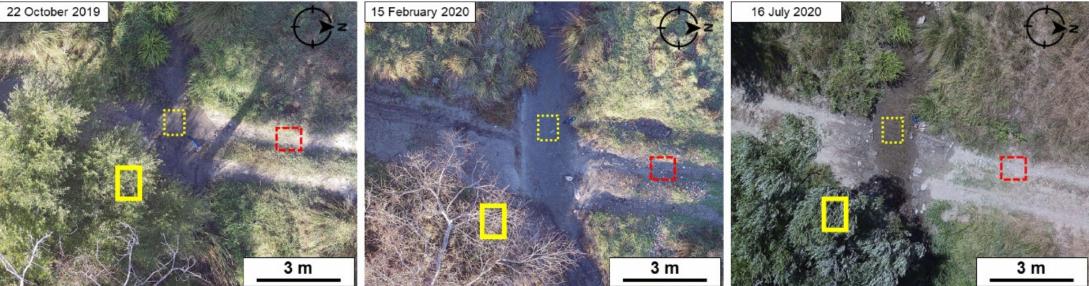
Figure 2. Some examples of the delimitation with polygons of the control matrix of water (yellow dots polygon), soil (red dashed polygon), and vegetation (yellow polygon) in three different survey